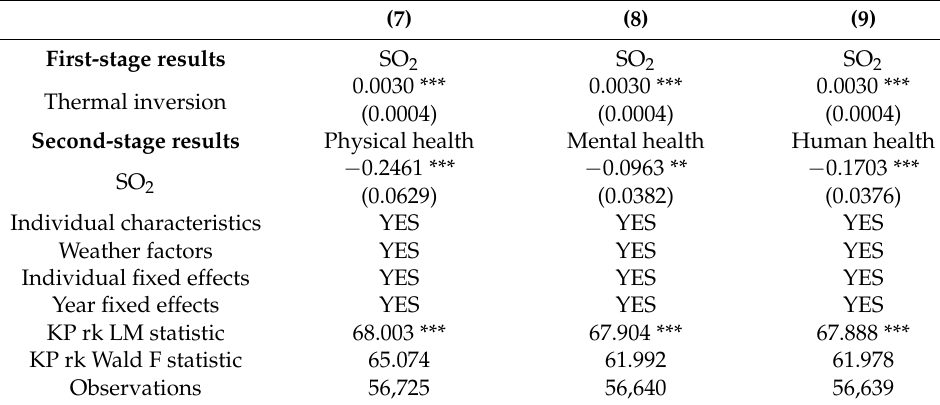
Table 4. Replacing the core independent